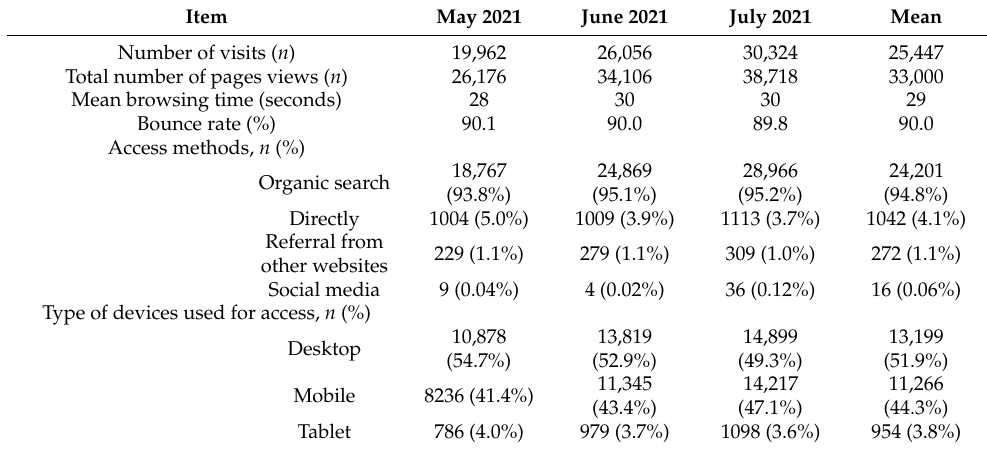
Table 2. Data collection using Google